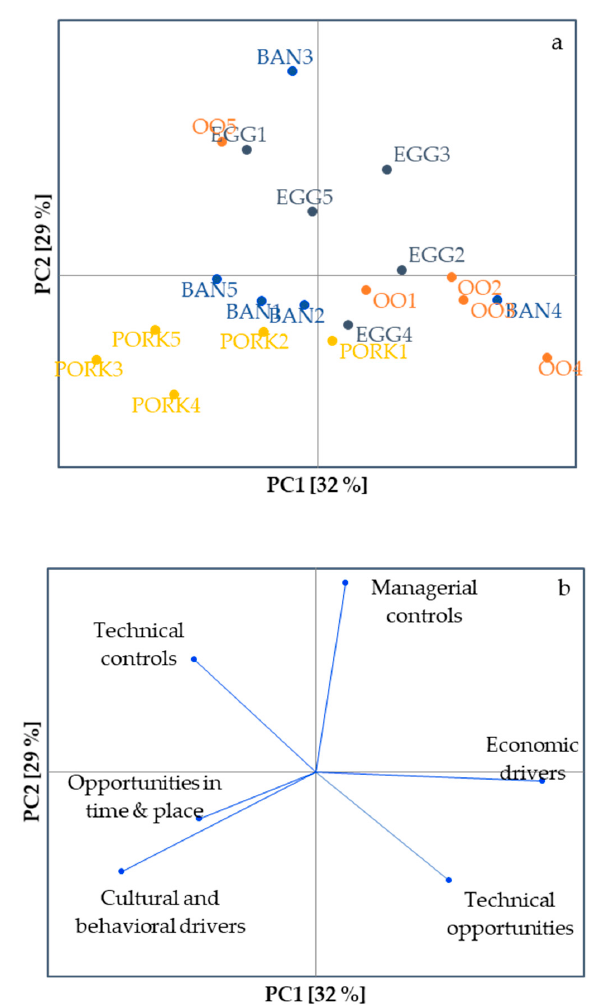
Figure 2. First two dimensions of a principal component analysis on the high risk answer frequencies of the six fraud factor categories provided by the banana (BAN), egg (EGG), olive oil (OO) and pork (PORK) supply chain actors: ( a ) scores plot; ( b ) loadings plot. Actors are indicated by their supply chain code followed by a number (e.g., BAN1).